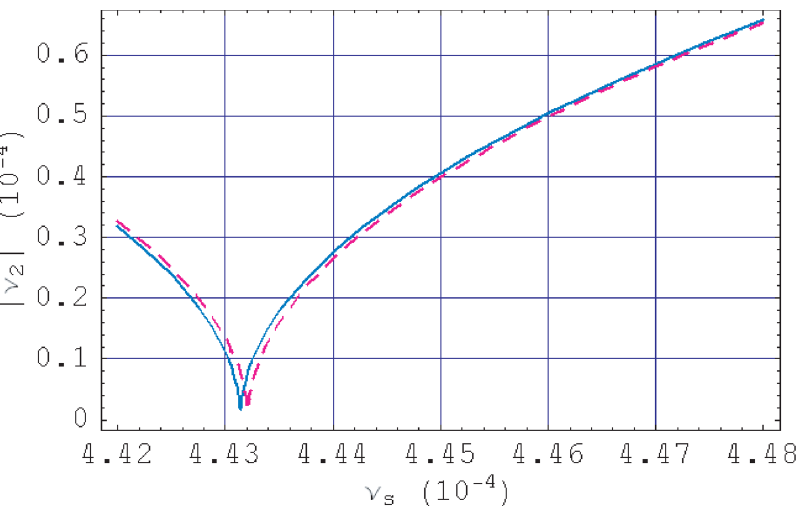
(cid:4) 0 : 51 , and we plot the absolute value of x (cid:4) 0 resonance. We have set the dispersion at the crab cavity s